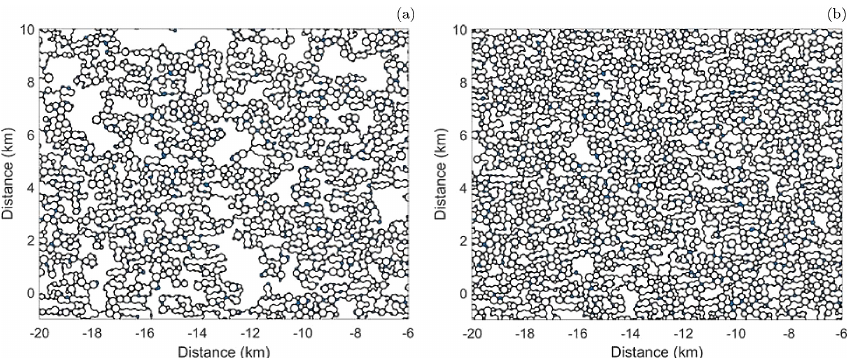
Figure 15. Fragments of the model domain at the end of the reference simulation, with T = 25s ( a ; wavelength L = 976m), and a simulation with T = 23s ( b ; wavelength L = 826m), showing the pattern of floes. The wave propagation direction is from top to bottom. Note that the whole area of both panels is covered with ice; i.e., the large white spaces are large floes, not open water.